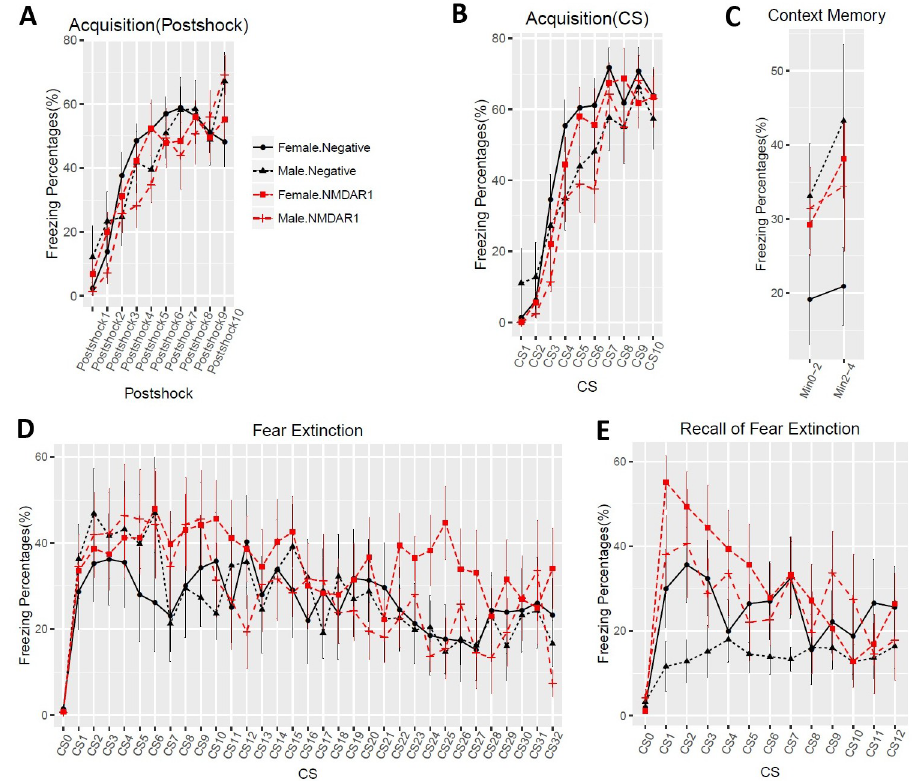
Fig 10. Effects of the anti-NMDAR1 autoantibodies on fear conditioning in the large replication cohort. (A) In Day 1 fear acquisition, there is neither sex (F(1,36) = 0.16, p = 0.69) nor autoantibody (F(1,36) = 0.45, p = 0.51) effect on post-shock freezing time. (B) Neither sex (F(1,36) = 1.79, p = 0.19) nor autoantibody (F(1,36) = 0.53, p = 0.47) effect was observed during CS tone. (C) In Day 2 context memory, neither sex (F(1,35) = 2.05, p = 0.16) nor autoantibody (F (1,35) = 0.55, p = 0.46) effect was observed. (D) In Day 3 fear extinction, there is no sex effect (F(1,35) = 0.25, p = 0.62) or autoantibody effect (F(1,35) = 0.52, p = 0.48). CS0: pre-tone. (E) In Day 4 recall of fear extinction, neither sex (F (1,35) = 1.26, p = 0.27) nor autoantibody (F(1,35) = 2, p = 0.17) effect was observed. However, there is a significant interaction (F(12,420) = 2.96, p = 0.00056) between the autoantibody and CS. CS0: pre-tone. All data are present as